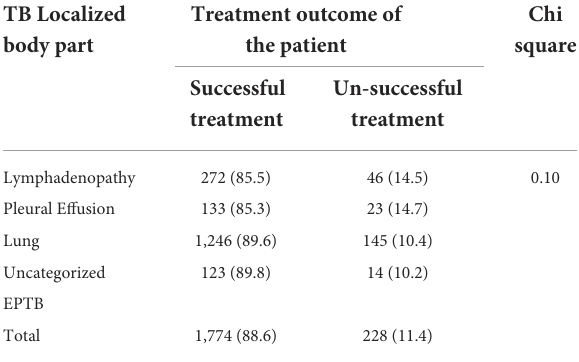
TABLE 4 Treatment outcome of pediatrics EPTB among children attending treatment in selected health institutions of eastern Ethiopia, 2017 ( n =